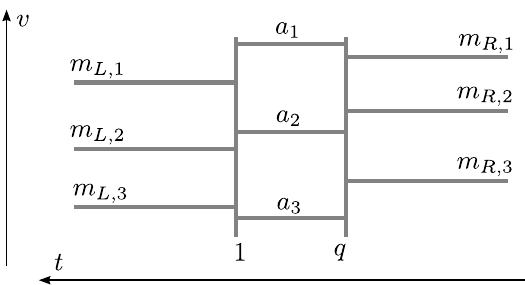
Figure 2 . This (cid:12)gure illustrates the position of the branes (horizontal D4s and vertical NS5s) for the case of the N = 2 SU(3) gauge theory. In the N = 1 case, one needs to introduce an orbifold and image branes as reviewed in [28]. From the equation for the curve (2.3), we see that for t ! 0 = 1 the solutions of the curve are v = m L;i =m R;i , while for v ! 1 the solutions are t = 1 ; q . The SCQCD